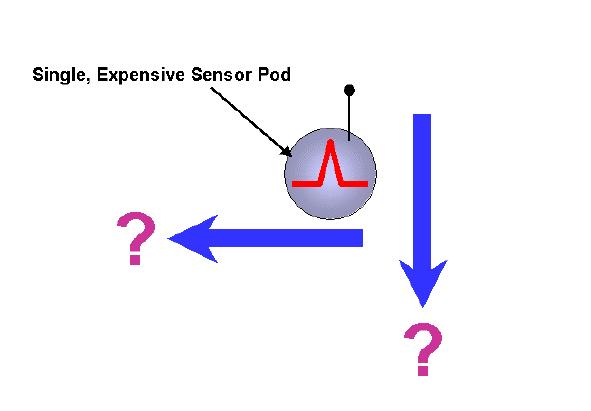
Figure 2. Here, cheaper sensors are used with a presumed reduction in measurement fidelity.